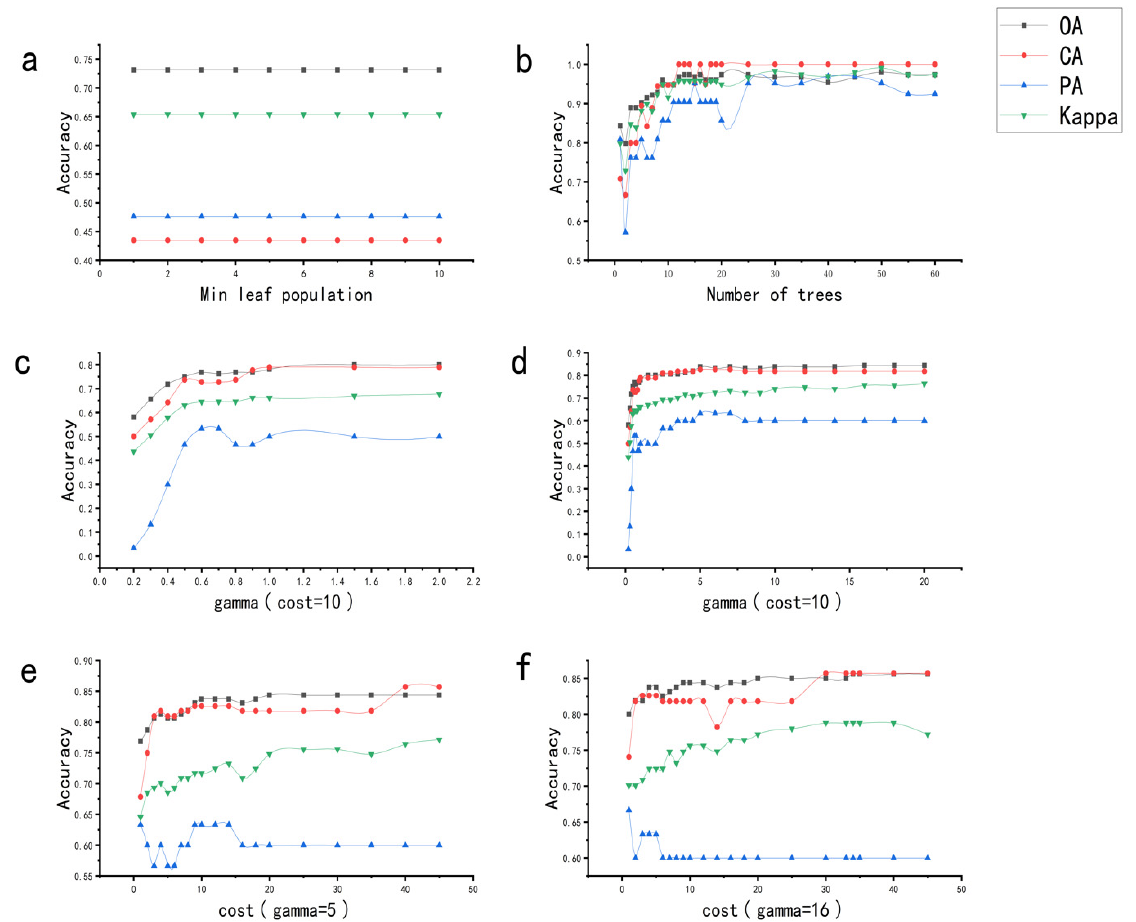
Figure 6. Accuracy index statistics of each algorithm. ( a ) The result of CART; ( b ) the result of RF; ( c ) the result of SVM when cost is 10 and gamma changes between 0.2 and 0.6; ( d ) the result of SVM when cost is 10 and gamma changes between 0.2 and 20; ( e ) the result of SVM when gamma is 5; ( f ) the result of SVM when gamma is 16.